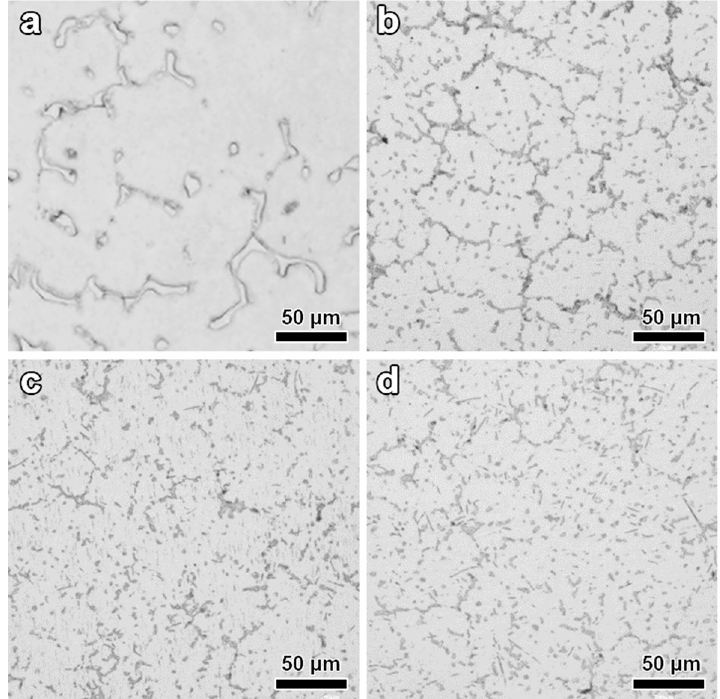
Figure 2. The optical micrographs of ( a ) AZ91, ( b ) AZ91–0.5La, ( c ) AZ91–1.0La and ( d ) AZ91–1.5La.